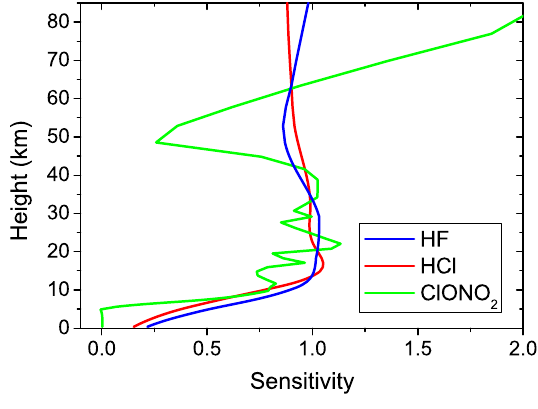
Fig. 1. Height dependency of the sensitivity of the retrieval as de- fined by Vigouroux et al. (2008) for HF (blue line), HCl (red line), and ClONO 2 (green line). This total column sensitivity describes the change in the retrieved total column, 1 col retr , which results from a partial column change 1 col inp (h) applied at altitude h . The resulting sensitivity is given by sens (h) = 1 col retr /1 col inp (h) . The curves shown represent mean values each calculated from six ar- bitrary spectra with different solar elevation angles ranging from about 2 to